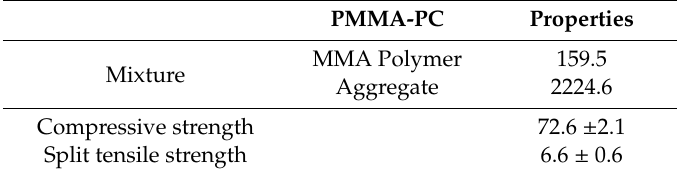
Figure 2. Polymer concrete production. Table 1. Mixture Proportions of PMMA-PC (kg / m 3 ) and Mechanical Properties (MPa).